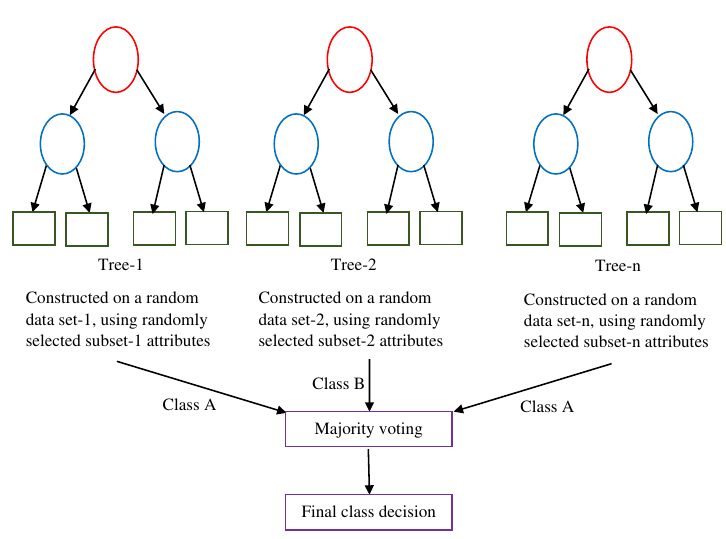
Fig. 7 Structure of Random Forest